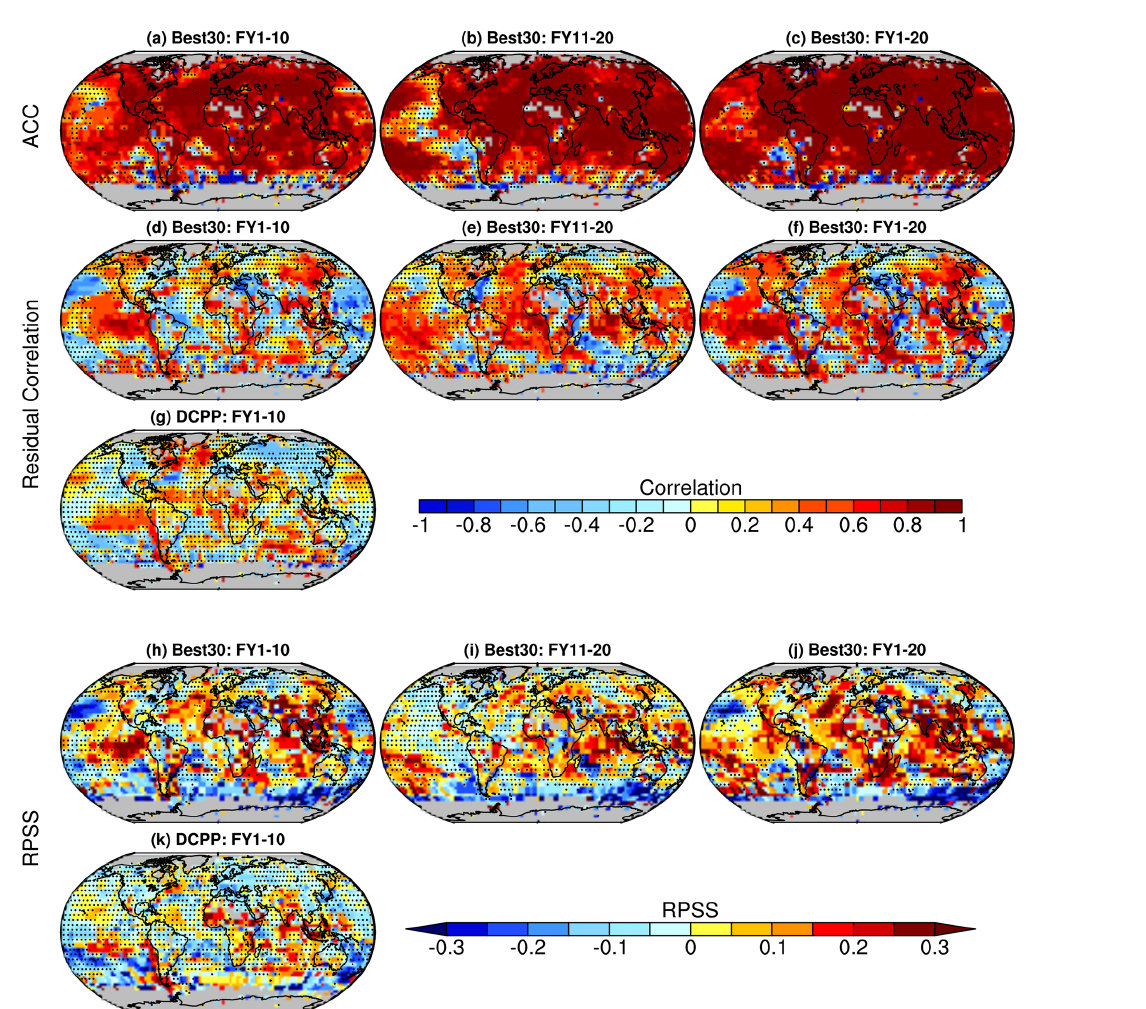
Figure 2. Anomaly correlation coefficient (ACC) between observed and predicted near-surface temperature anomalies for three forecast periods, average of forecast years 1–10, 11–20, and 1–20 (a–c) . Residual correlations for Best30 (d–f) and for DCPP (g) ensemble means after removing the forced signal (estimated based on ensemble mean of the unconstrained 212 members following Smith et al., 2019). RPSS for Best30 (h–j) and for DCPP (k) against the unconstrained CMIP6 ensemble as reference. Stippling indicates regions where the ACC, residual correlation, and RPSS are statistically not significant at 95% confidence level (see Methods for